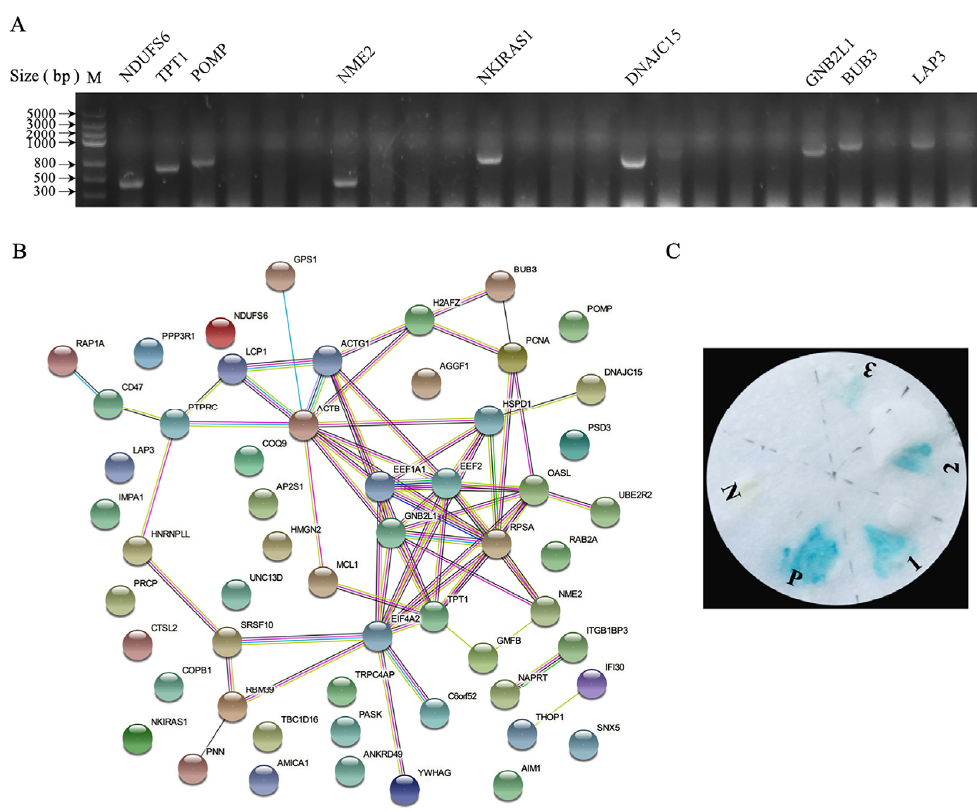
Figure 2. Yeast two-hybrid screen of p17 interacting proteins. ( A ) Confirmation of positive clones by PCR. ( B ) PPI network analysis. The network of cellular proteins interacting with ARV p17 was constructed using STRING 11.5. ( C ) The colony-lift assay of p17 and selected proteins. N, negative control; P, positive control; 1, eEF2; 2, TPT1; 3, Bub3. Table 1. The screening result of chicken spleen cDNA using ARV p17.